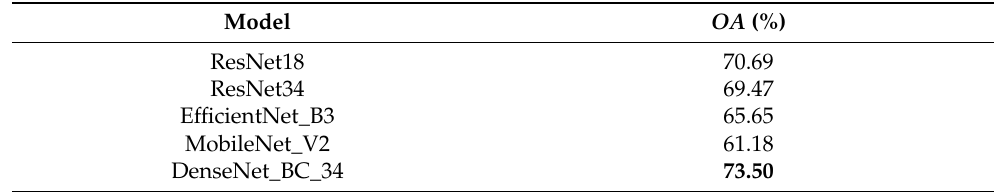
Table 3. Overall accuracy of different models on the test dataset.